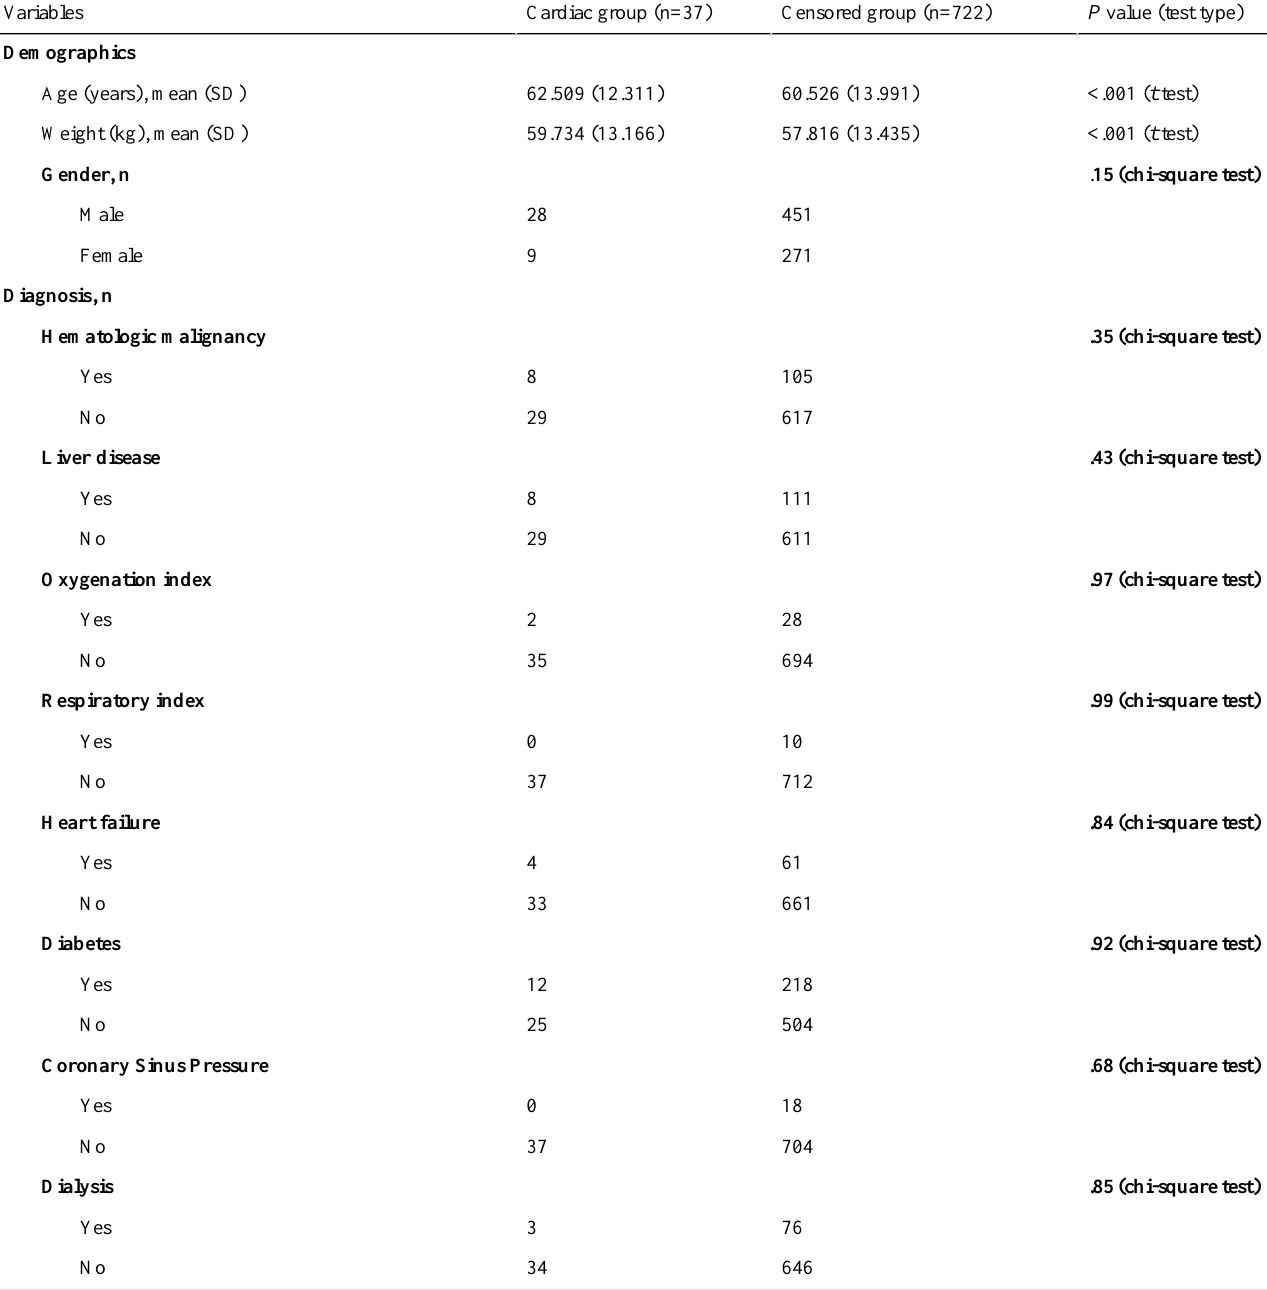
Table 1. Descriptive statistics of the demographics and underlying diseases of the